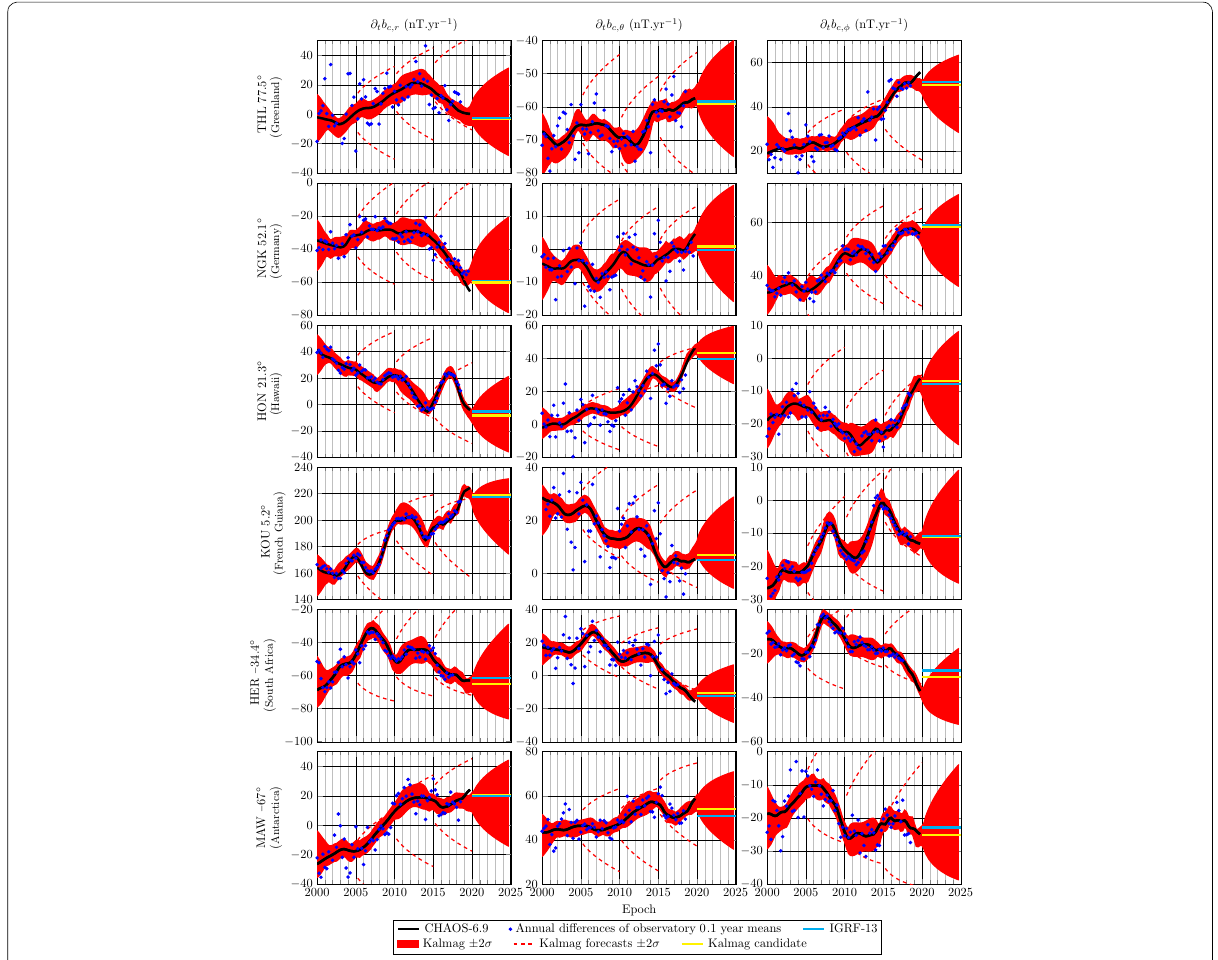
Fig. 4 Time series between 2000.0 and 2025.0 of the radial (left) azimuthal (middle) and longitudinal (right) secular variation evaluated at the level of the following ground-based observatories: Qaanaaq (THL), Niemegk (NGK), Honolulu (HON), Kourou (KOU), Hermanus (HER) and Mawson (MAW). Blue dots correspond to annual differences of ground-based observatory measurements averaged over 0.1 years. Black lines are derived from the CHAOS-6.9 SV model of Finlay et al. (2016). The blue and yellow lines are, respectively, the IGRF-13 and the Kalmag candidate SV. The red area is the Kalmag mean secular variation 2 standard deviation. Red dashed lines are the mean SV 2 standard deviation coming from 5 year forecast ± ±